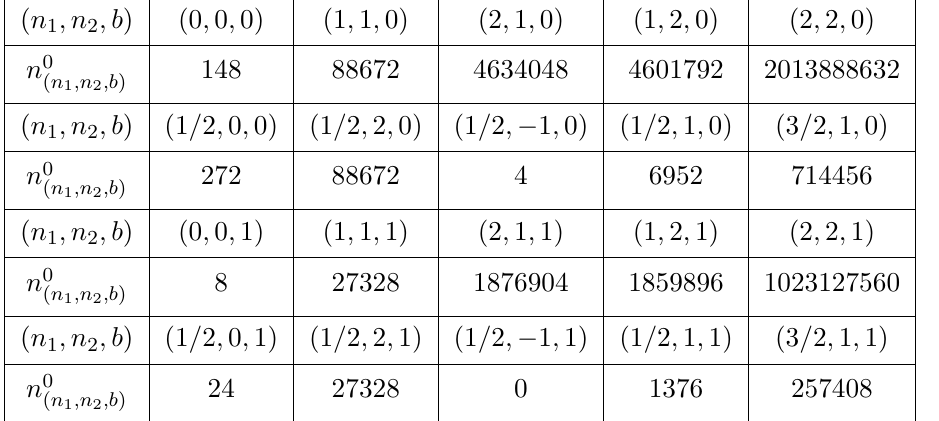
Table 9 . 2 A orbifold, non-standard embedding, with single Wilson line. Shift is given by, (cid:13) =